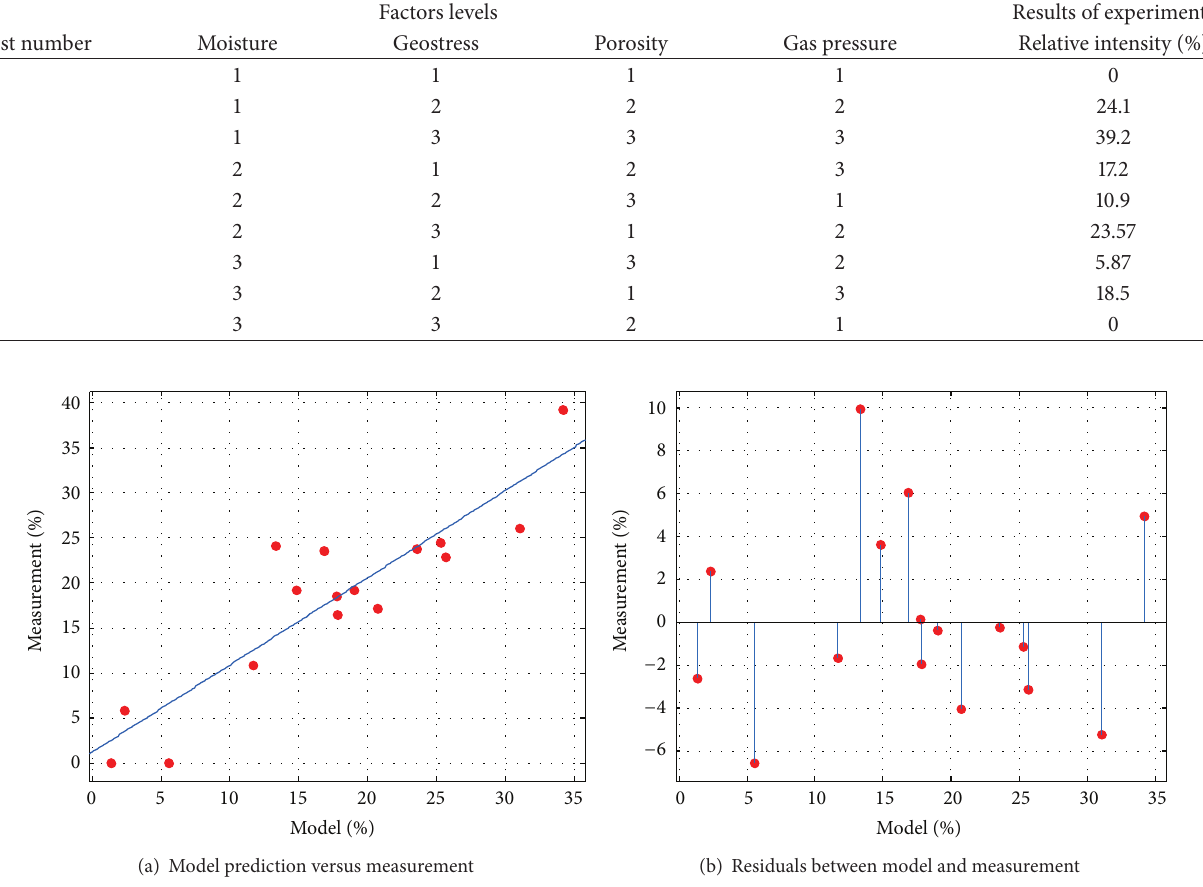
Figure 8: Evaluation of model predication ( 𝑅 -square: 0.8097 RMSE: